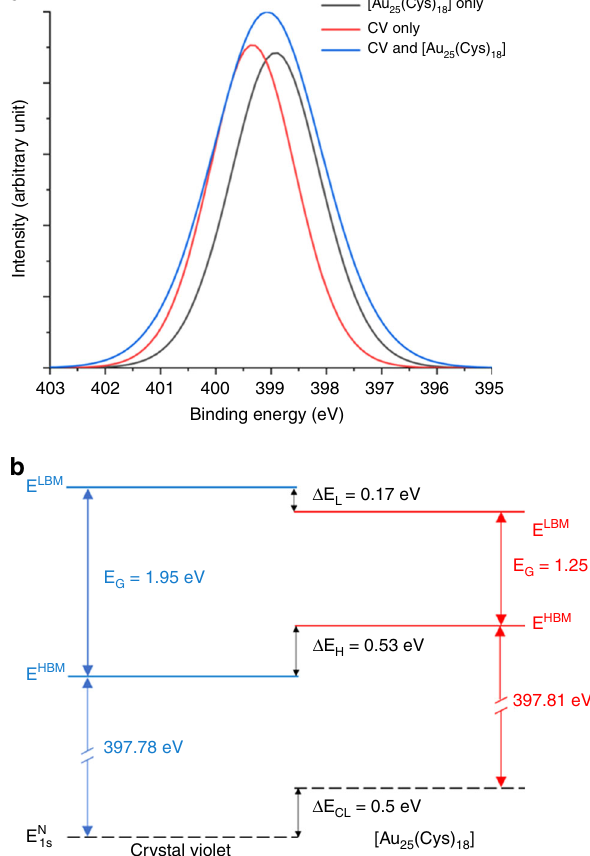
Fig. 6 Band alignment of crystal violet and [Au 25 (Cys) 18 ] from XPS. a N 1s spectra taken from CV only, [Au 25 (Cys 18 )] only and CV&[Au 25 (Cys) 18 )]. Experimental data shown as blue line are fi tted with the peak shapes Prompt (no sample) derived from phase-pure crystal violet (red line) and [Au 25 (Cys) 18 ] (black CV only CV and [Au 25 (Cys) 18 ] line). b XPS band alignment between crystal violet and [Au 25 (Cys) 18 ]. CV indicates crystal violet. E HBM is homo band maximum energy. Δ E H is the energy offset between CV E HBM and [Au 25 (Cys) 18 ] E HBM . E LBM is lumo band maximum energy. Δ E L is the energy offset between CV E LBM and [Au 25 (Cys) 18 ] E LBM . Δ E CL is the core level offset between the N 1s core levels.